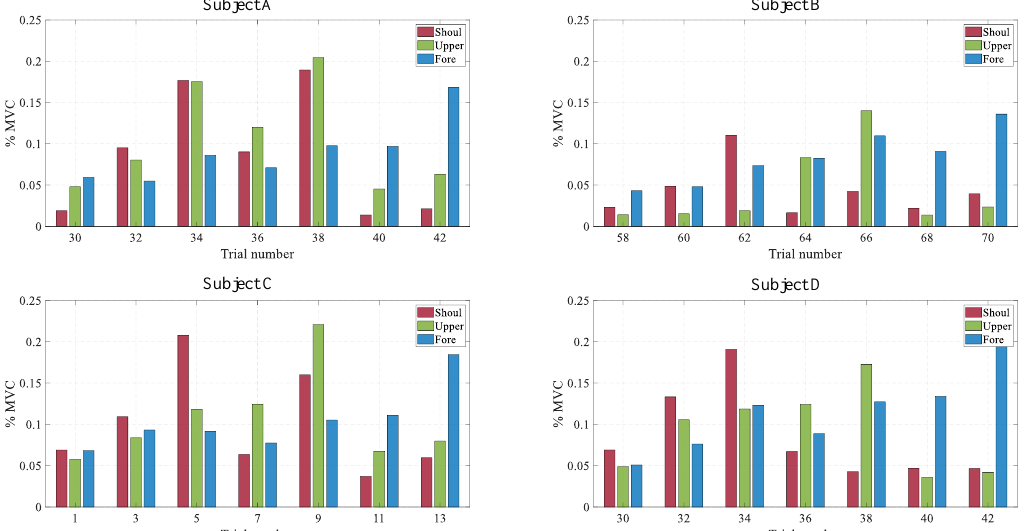
Figure 7. Percentage of MVC value of each muscle group for every subject at one selected position. The colors red, green and blue respectively represent the activation level of the shoulder muscle group, upper arm muscle group and forearm muscle